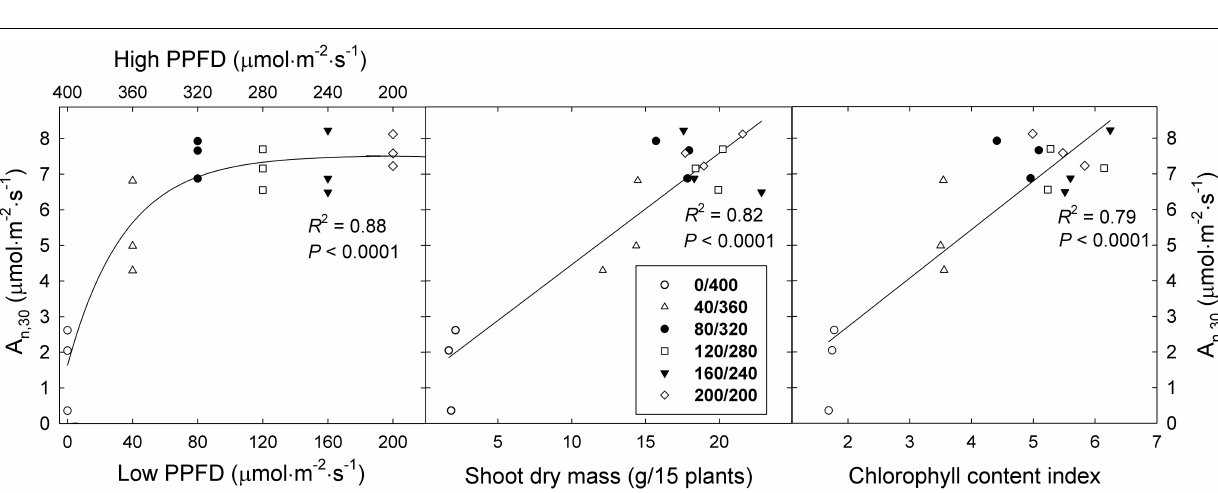
The A n , 30 of ‘Green Salad Bowl’ lettuce increased asymptotically as the lower PPFD increased from 0 to 200 µ mol · m − 2 · s − 1 (and the high PPFD decreased from 400 to 200 µ mol · m − 2 · s − 1 ), with little or no difference among